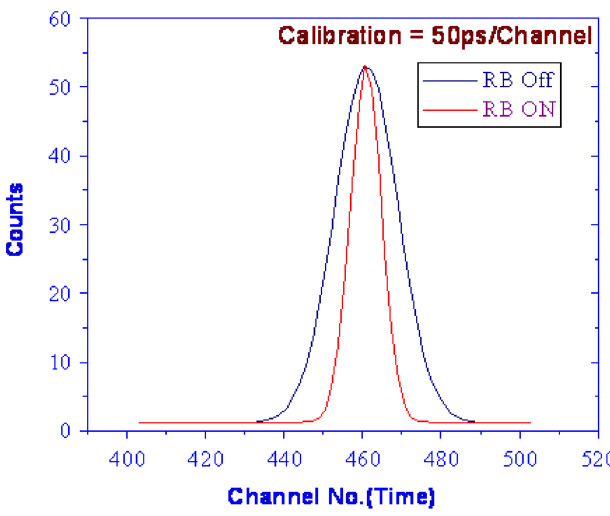
FIG. 17. (Color) Pulse length of 28 Si beam at the target